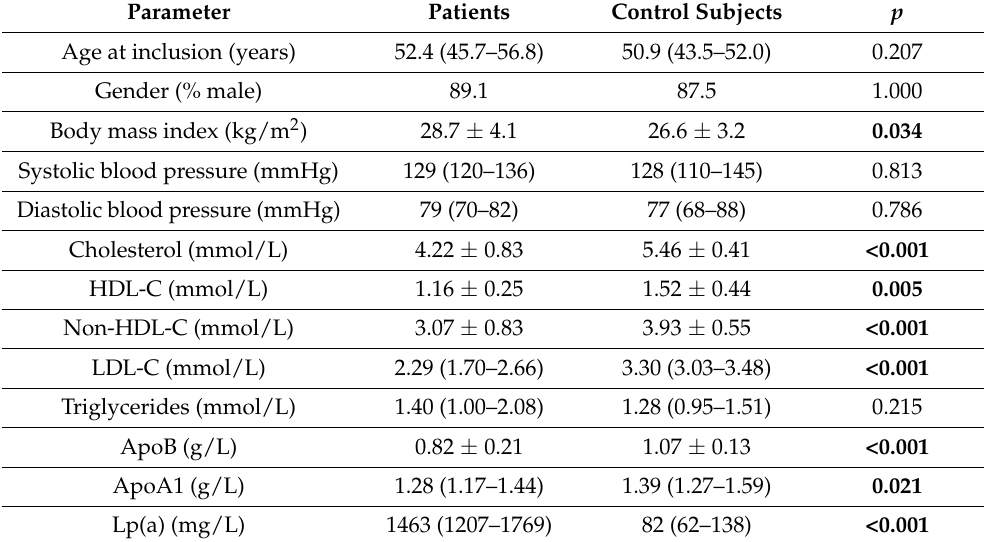
Table 2. Characteristics of patients (N = 64) and control subjects (N = 16) at enrollment.